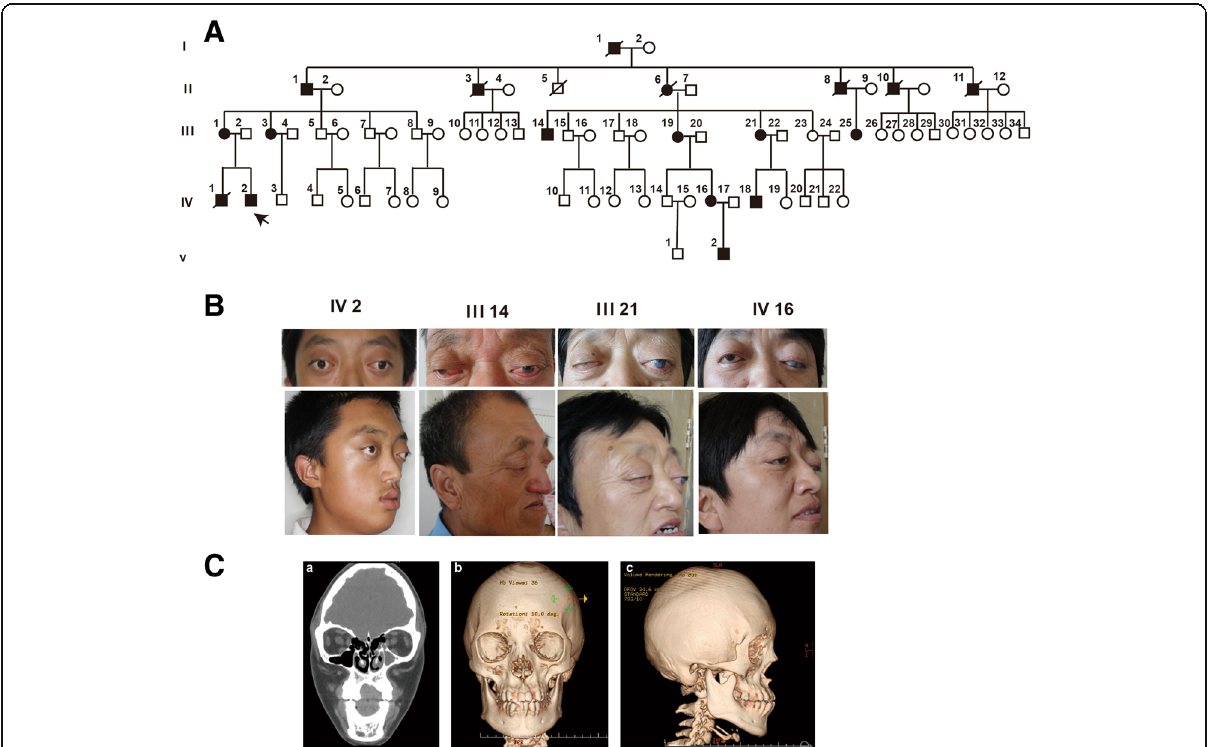
Fig. 1 Crouzon syndrome patients and morphology measurement of orbit. a Five-generation Crouzon syndrome pedigree. Affected individuals are indicated by filled symbols, the proband is marked with an upward arrow. b Facial photographs of the Crouzon syndrome patients. c Morphology measurement of orbit. (Ca) Three-dimensional reconstruction of skull of the proband IV-2 (Cb) Morphology measurement of orbit(a. midinterorbital distance, b.lateral orbital wall angle) (Cc) Morphology measurement of orbit(a. roof length, b. medial wall length, c. floor length, d. lateral wall length, e. orbital width, f. orbital